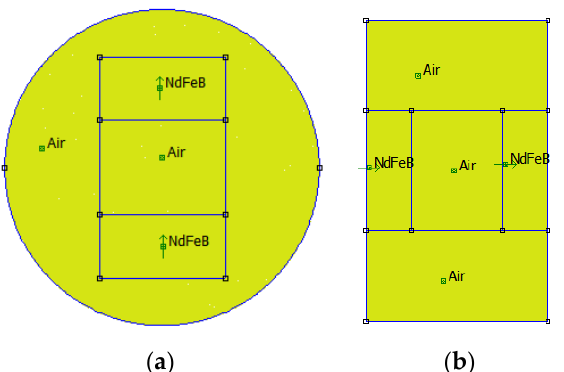
Figure 2. Finite element models for two test samples. ( a ) Type A − 20 (Front View); ( b ) Type B − 15 (Side View).